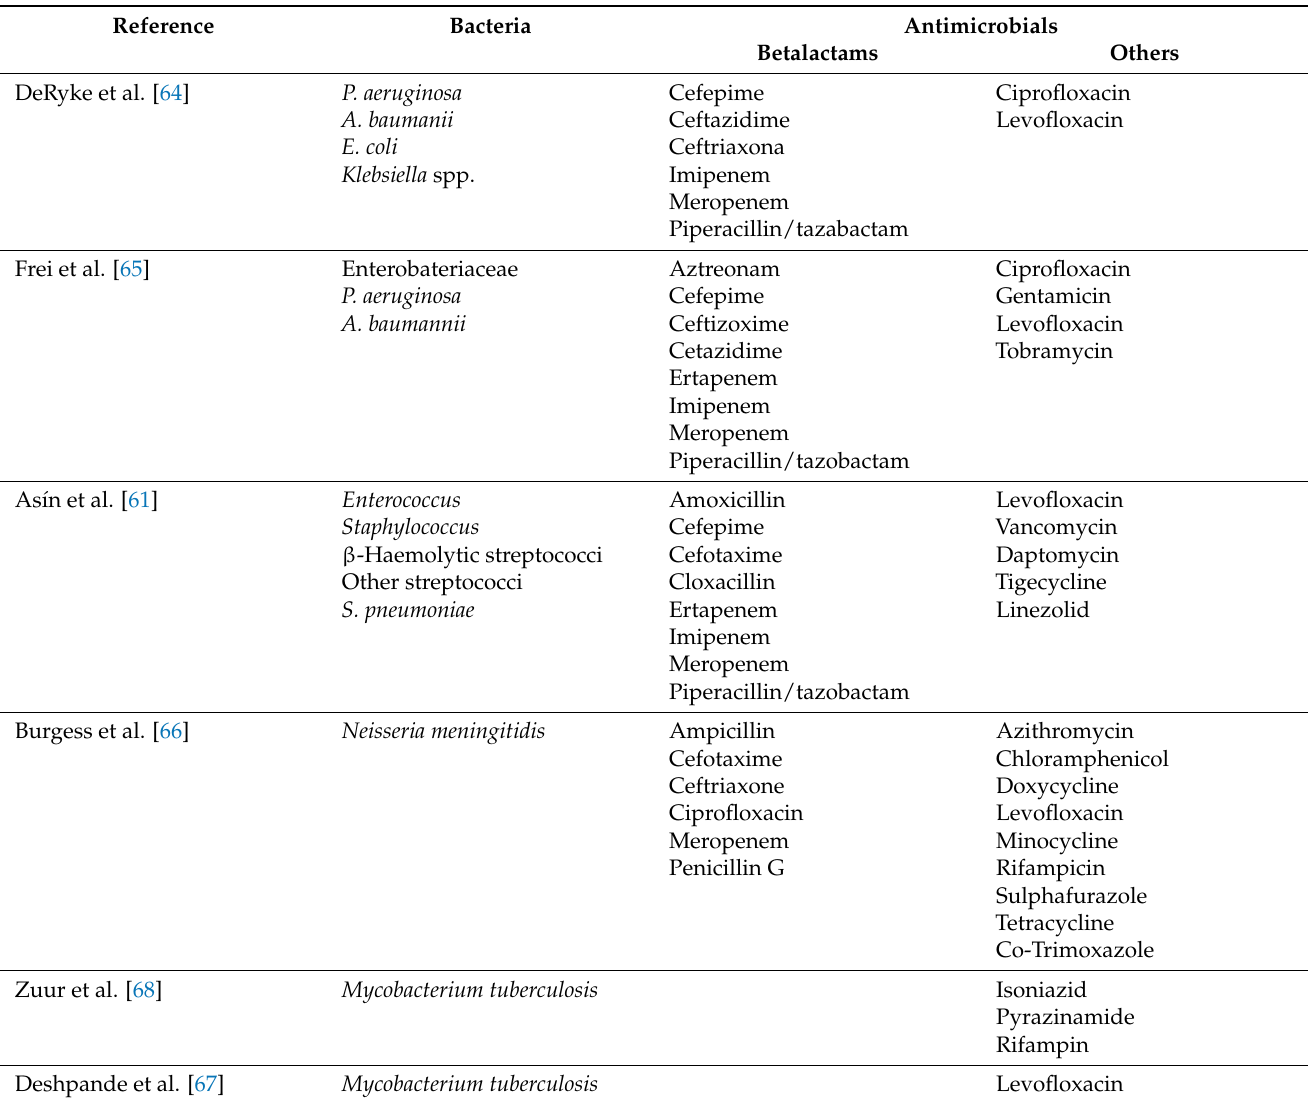
Table 2. Published studies that review breakpoints by applying the PK/PD criteria. Bacteria